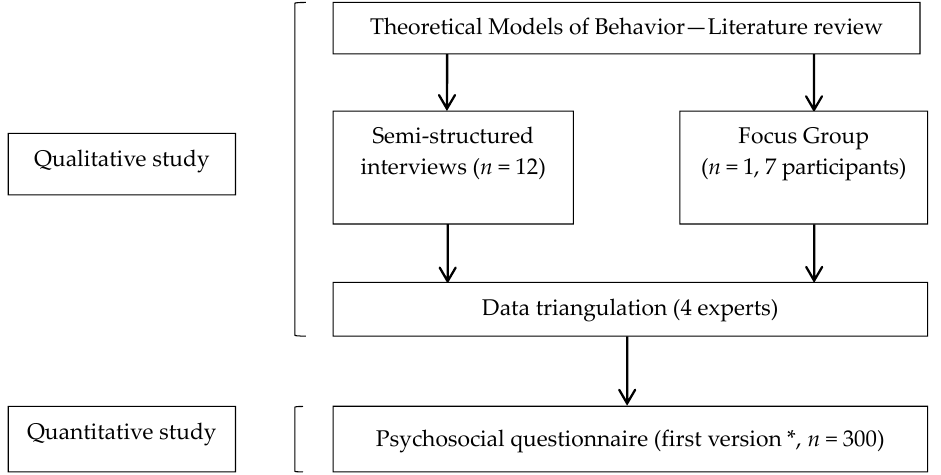
Figure 1. Main steps of the study. * This part of the study deals with the validation step of the psychosocial questionnaire. An adjustment step was led later on 30 women.